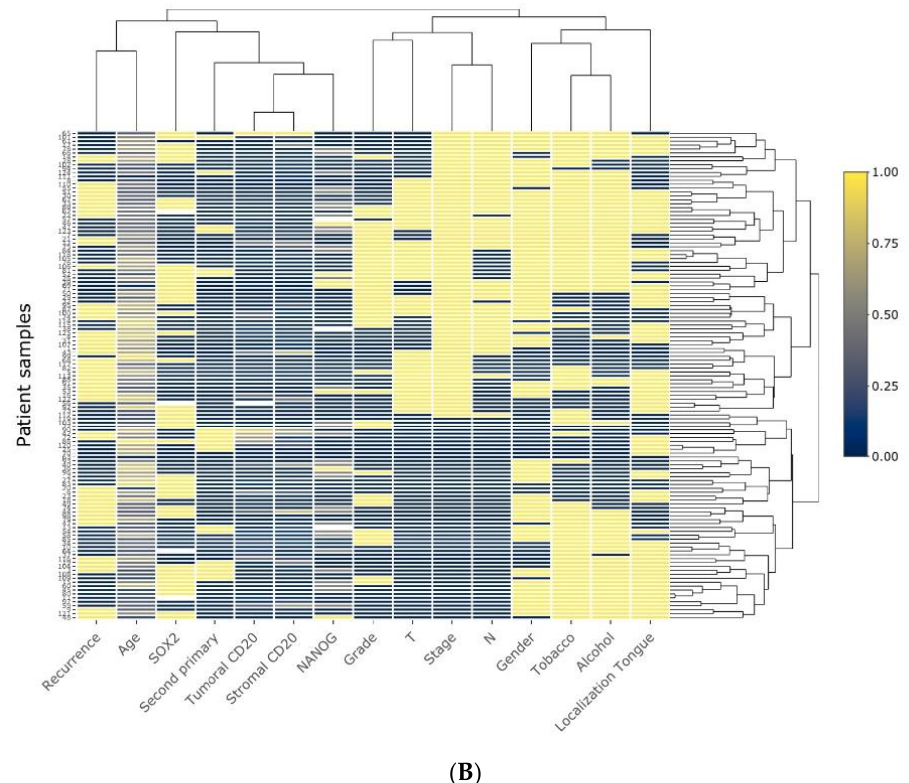
Figure 2. Heatmap and hierarchical clustering analysis to classify the different variables studied. ( A ) Heatmap displaying the IHC scores for the different immune profiles in both tumoral and stromal compartments. ( B ) Heatmap displaying the clinical characteristics, IHC scores for CD20 + B cell infiltration, Nanog, and SOX2 expression. All data sets were normal- ized.